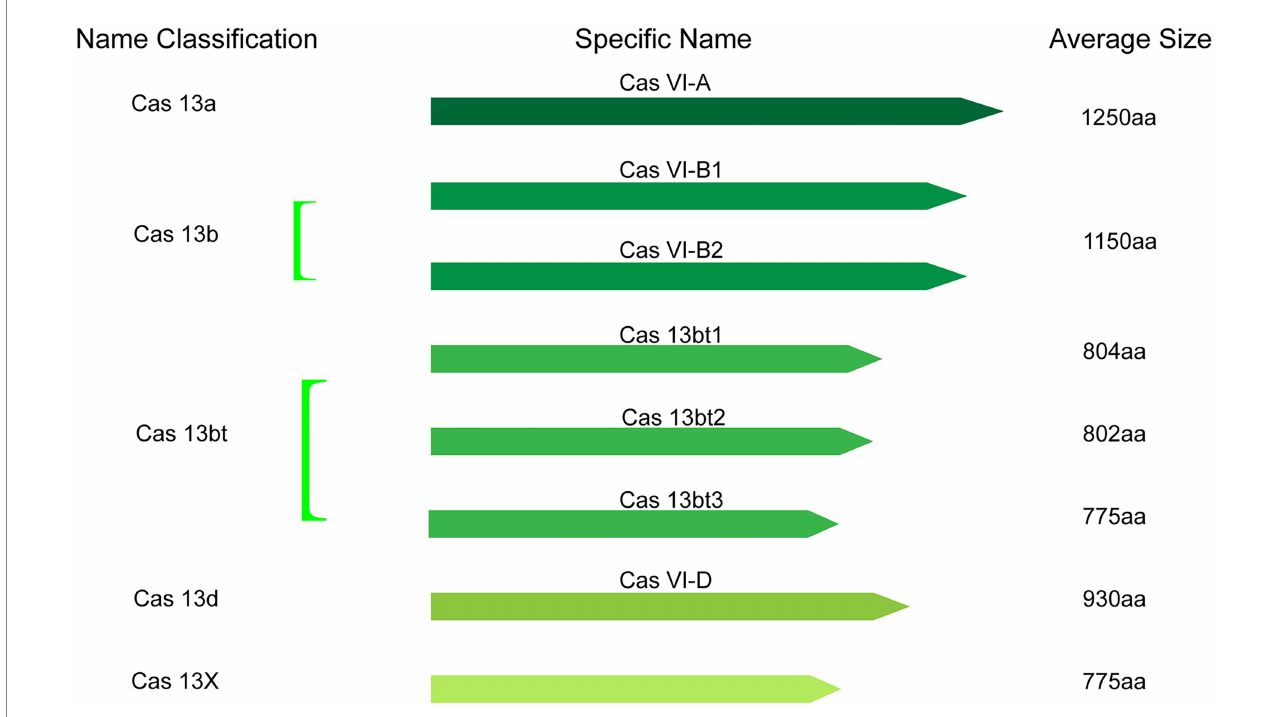
FIGURE 2 The classification and average size of Cas13 proteins with having been widely used in various